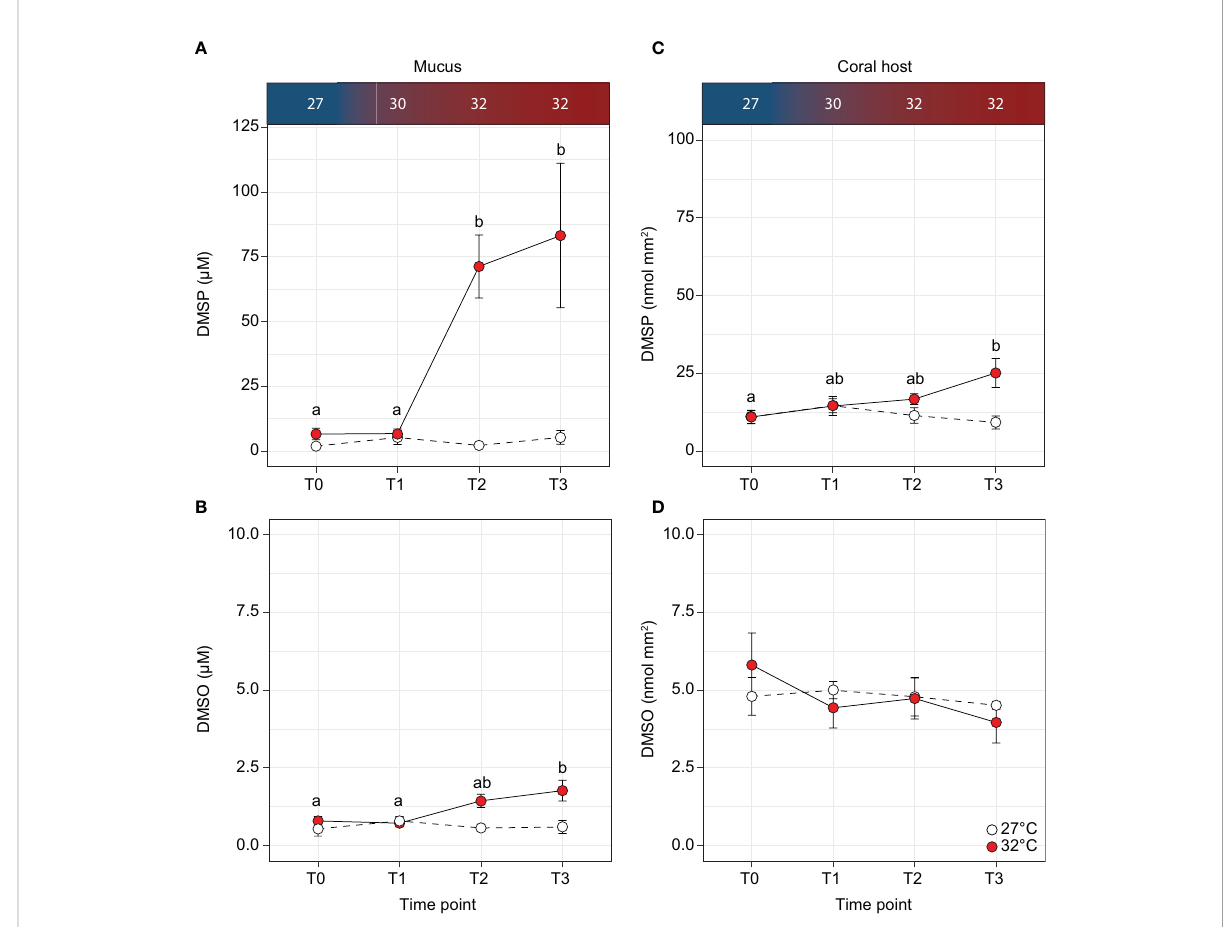
FIGURE 2 Concentrations of (A, C) dimethylsulphoniopropionate (DMSP) and (B, D) dimethylsulphoxide (DMSO) in the Acropora millepora mucus and coral host for the control (white circles) and temperature treatments (red circles). Letters indicate signi fi cant differences between timepoints for the treatments. Temperatures are indicated along the top panel for corresponding sampling time-points. Averages (± SE) are shown (n =